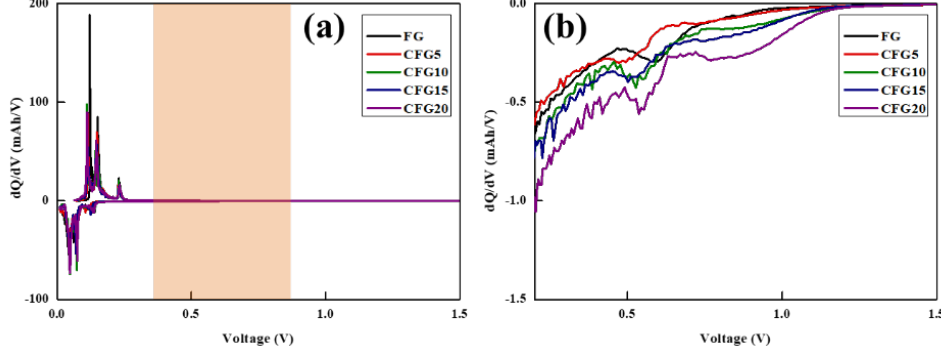
Figure 3. ( a ) Differential capacity (dQ/dV vs. V) curves at 1st cycle and ( b ) more detailed differential capacity of lithiation process.